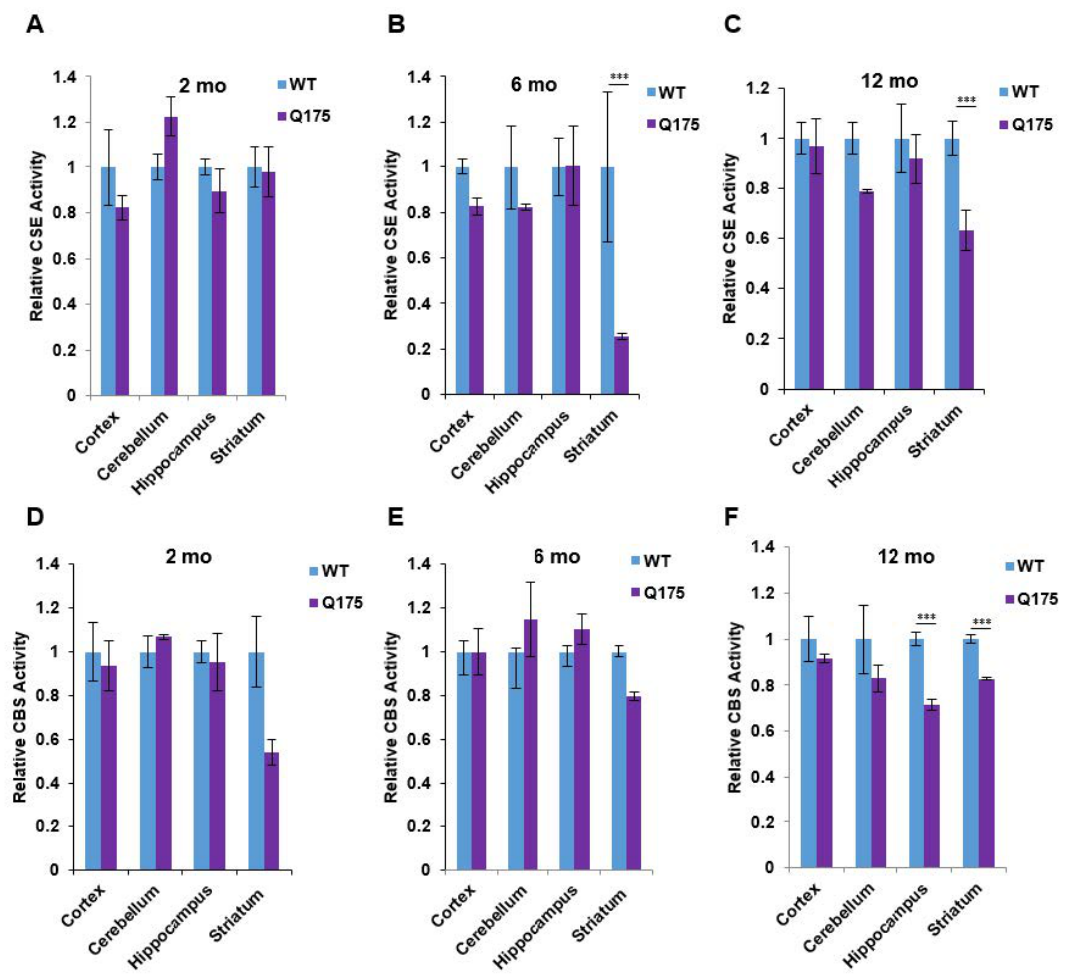
Figure 3. Enzymatic activities of cystathionine γ -lyase (CSE) and cystathionine β -synthase (CBS) in the Q175 model of Huntington’s disease. ( A – C ) Enzymatic activity of CSE at 2, 6, and 12 months in the cortex, cerebellum, hippocampus, and striatum in Q175 mice and their wild-type counterparts. H 2 S production from 10 mM L-cysteine in the presence of the cofactor, pyridoxal 5-phosphate (PLP at 250 mM), using the methylene blue assay ( D – F ). Enzymatic activity of CBS at 2, 6, and 12 months in the cortex, cerebellum, hippocampus, and striatum in Q175 mice and their wild-type counterparts. Activity was measured using the substrates for CBS (15 mM L-homocysteine and 10 mM L-cysteine) using the methylene blue assay. n = 3, SEM. * ** p < 0.001.